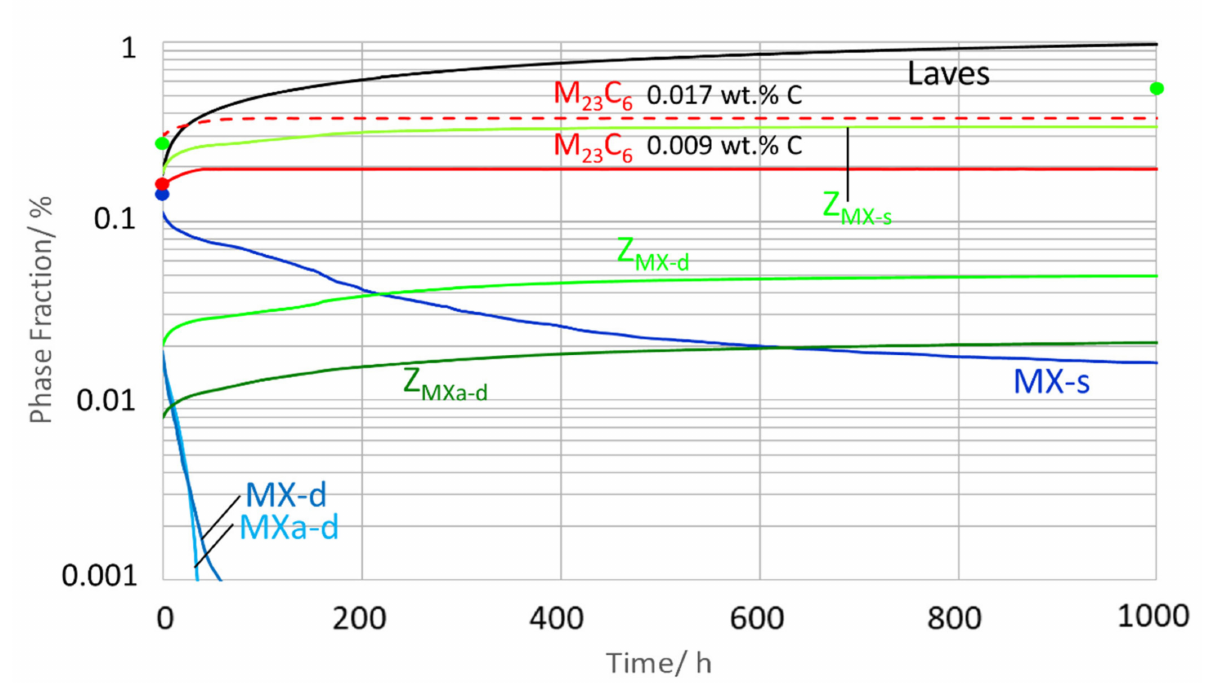
Figure 13. Simulated phase fractions during ageing of Z6 at 700 ◦ C (condition 1 up to condition